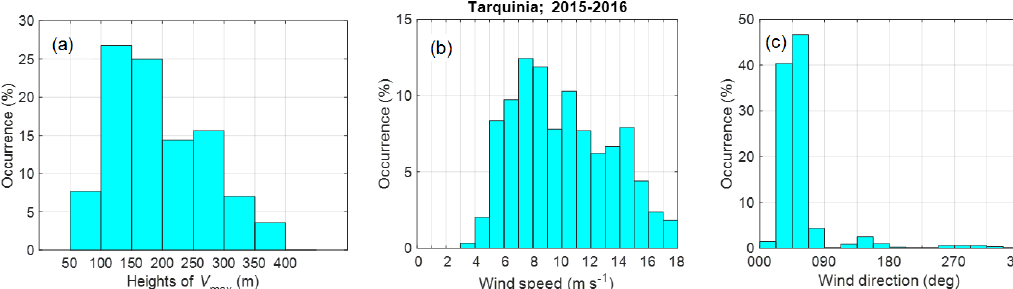
Figure 25. Histograms of ( a ) height of wind speed maximum, ( b ) wind speed, and ( c ) wind direction in the LLJ core.